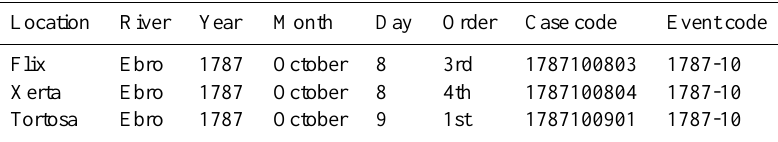
Table 1. Example of flood case and flood event